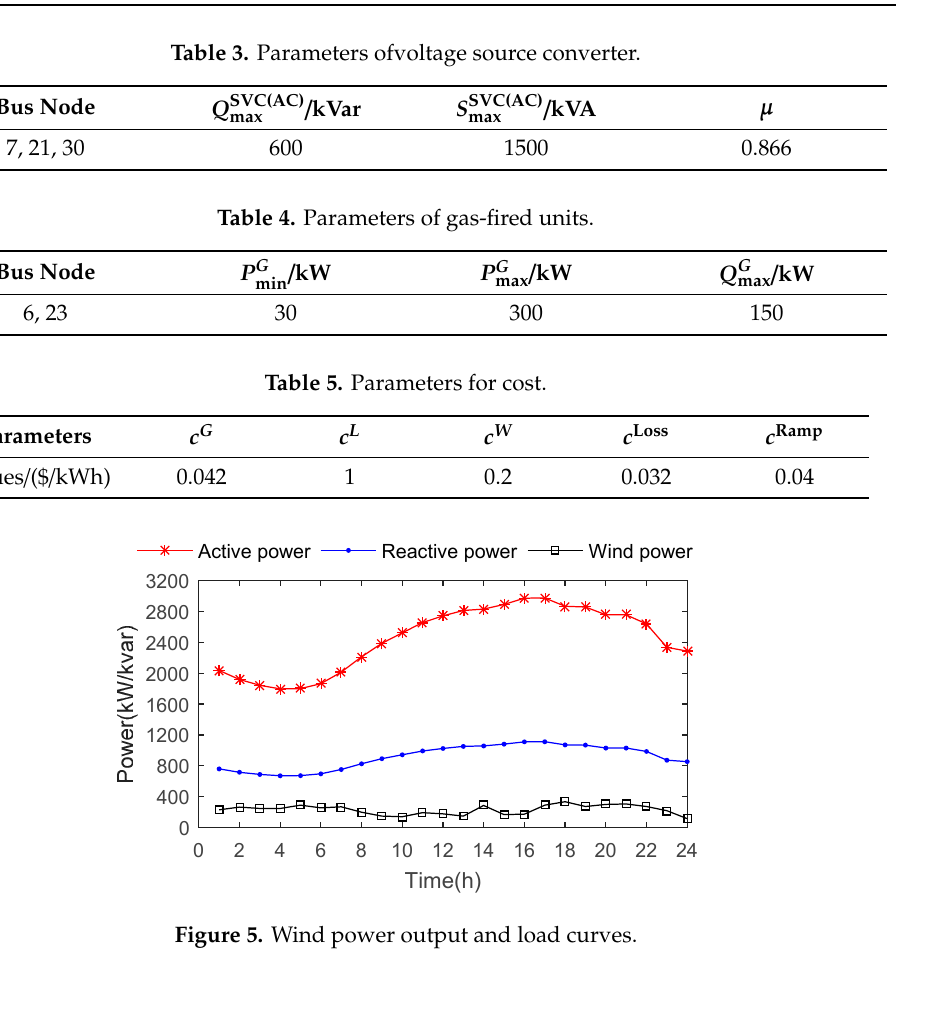
Table 6. Simulation results for different cases. Case 0 Table 7. Simulation results for different cases. Case